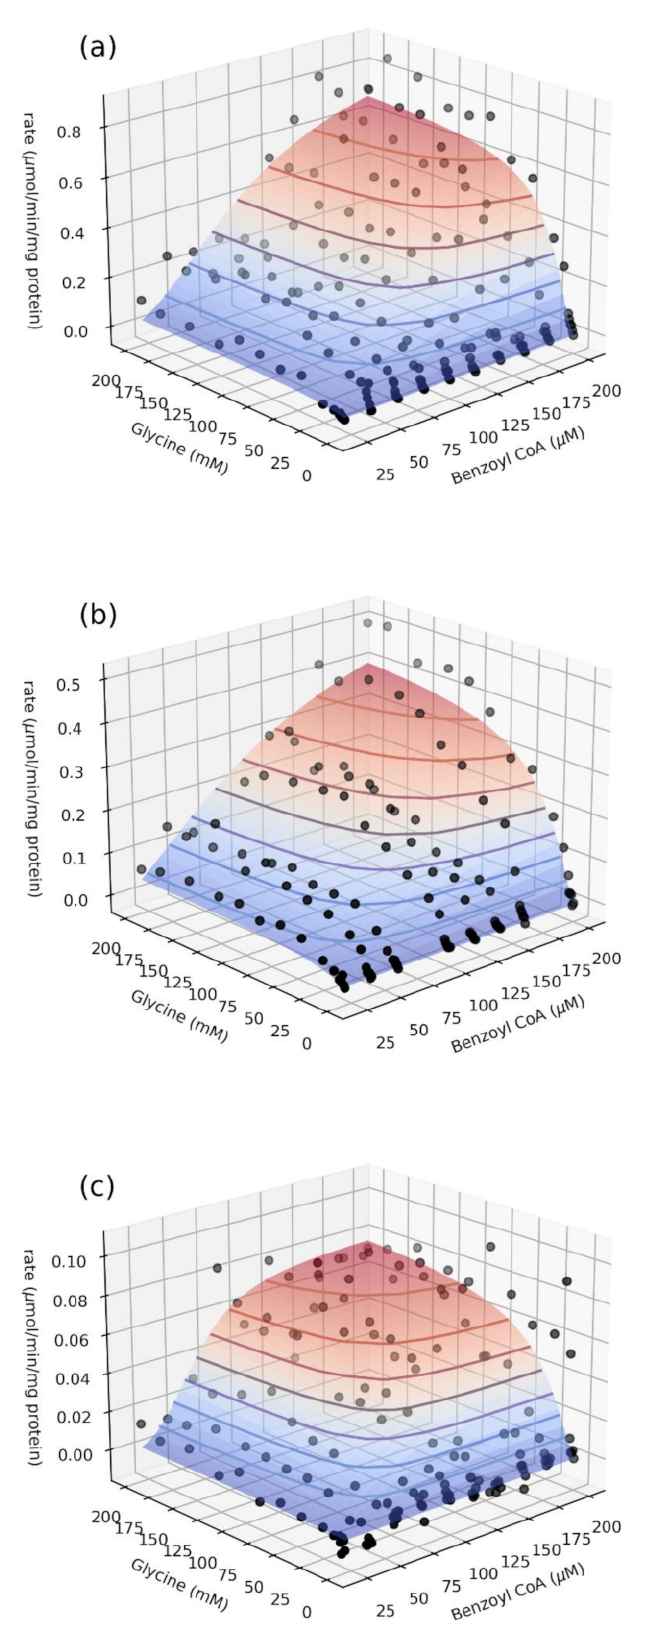
Figure 5. Global fit of initial rate data to the two-substrate Hill equation (see Section 3) for the haplotype variants 156Asn > Ser ( a ), 17Ser > Thr,156Asn > Ser ( b ), and 156Asn > Ser,199Arg > Cys ( c